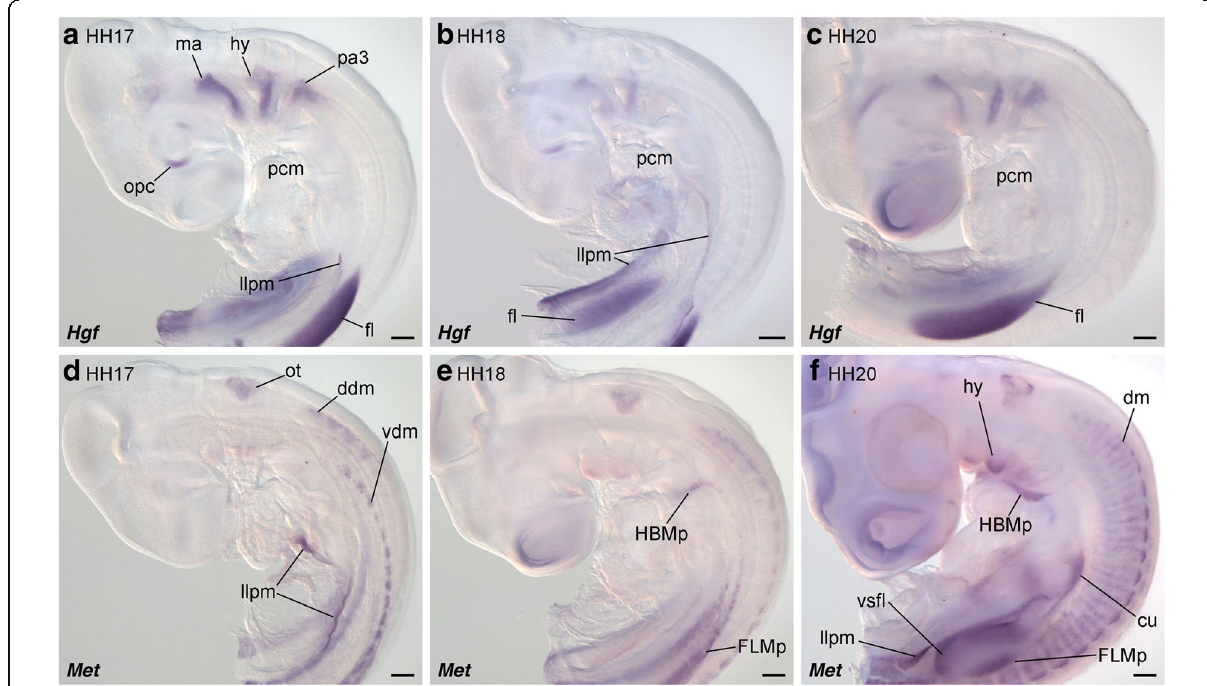
Fig. 2 Hgf and Met expression patterns in chicken embryos. Hgf ( a - c ) and Met ( d - f ) expression pattern in chicken embryos at stage 17 ( a , d ), 18 ( b , e ) and 20 ( c , f ). Lateral views. Hgf is expressed in the whole forelimb bud, but not in the migration route of HBM precursors. Met